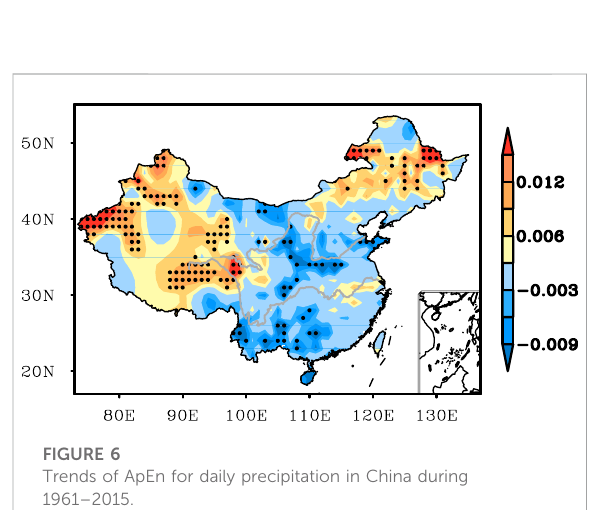
FIGURE 6 Trends of ApEn for daily precipitation in China during 1961 –